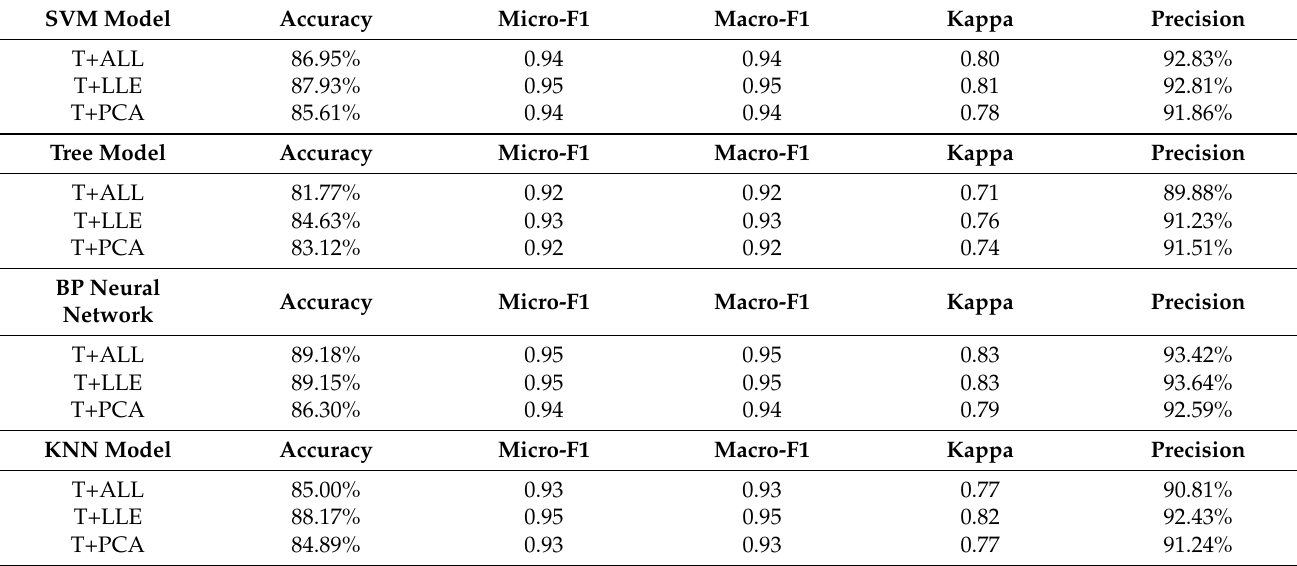
Table 2. Compare the multi-classification effect after dimensionality